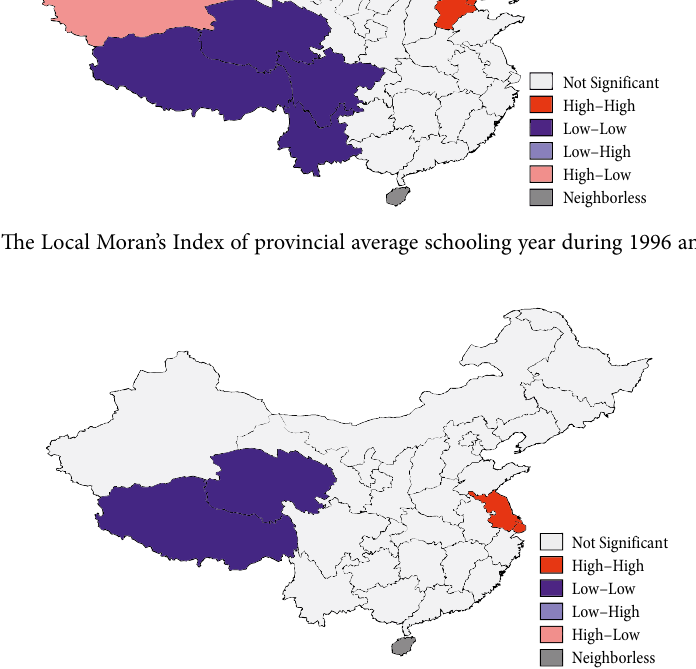
Fig. 3. The Local Moran’s Index of provincial education expenditure growth during 1996 and 2000